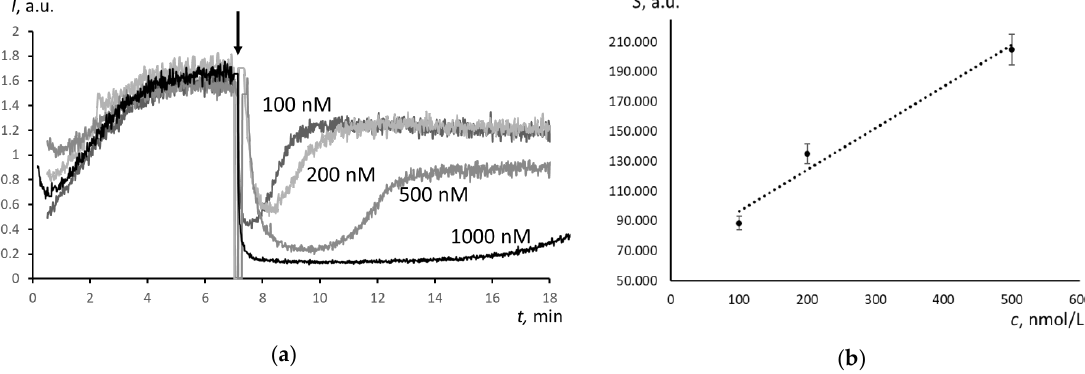
Figure 3. ( a ) Chemiluminescence plots for Umifenovir (concentrations are indicated in the figure), the chemiluminescent system consisted of 2.5 mM ABAP and 2 μM luminol, the arrow shows the moment of the addition of Umifenovir; ( b ) The calibration plot of the area of the “fast” depression on the Umifenovir concentration, n = 5.